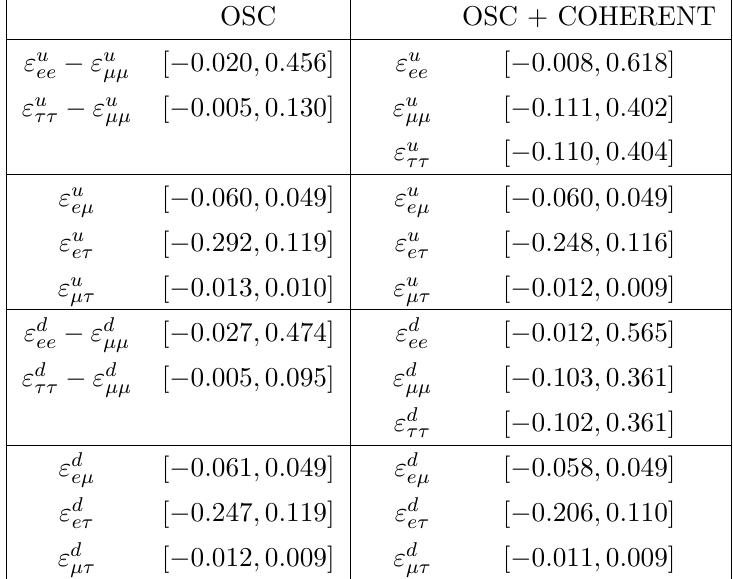
Table 1 . Recent constraints for the NSI parameters " u combined analysis of the oscillation experiments and COHERENT measurements